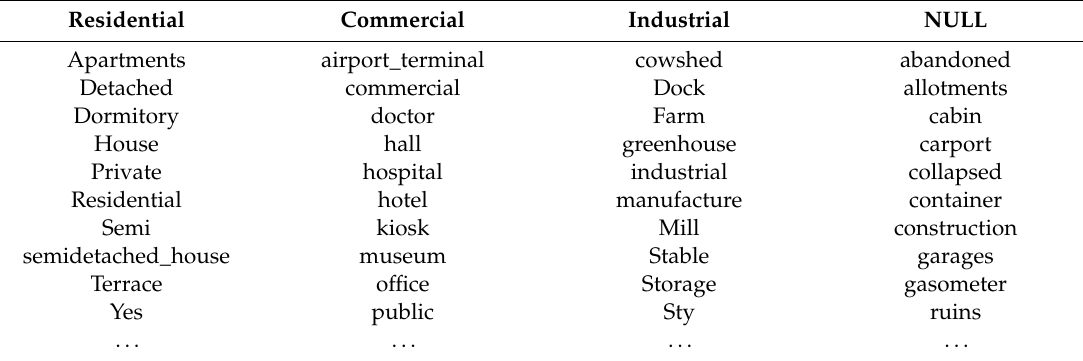
Table 1. Used OSM-tags (abstract) for the classification of